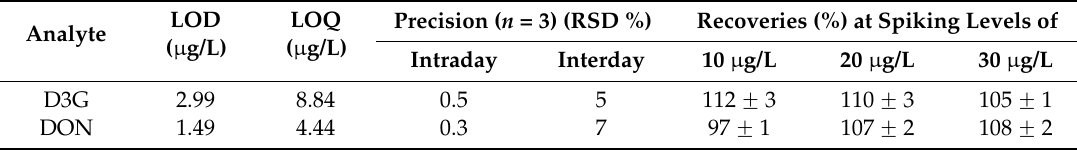
Table 2. Validation data of the stable isotope dilution assay of D3G and DON.